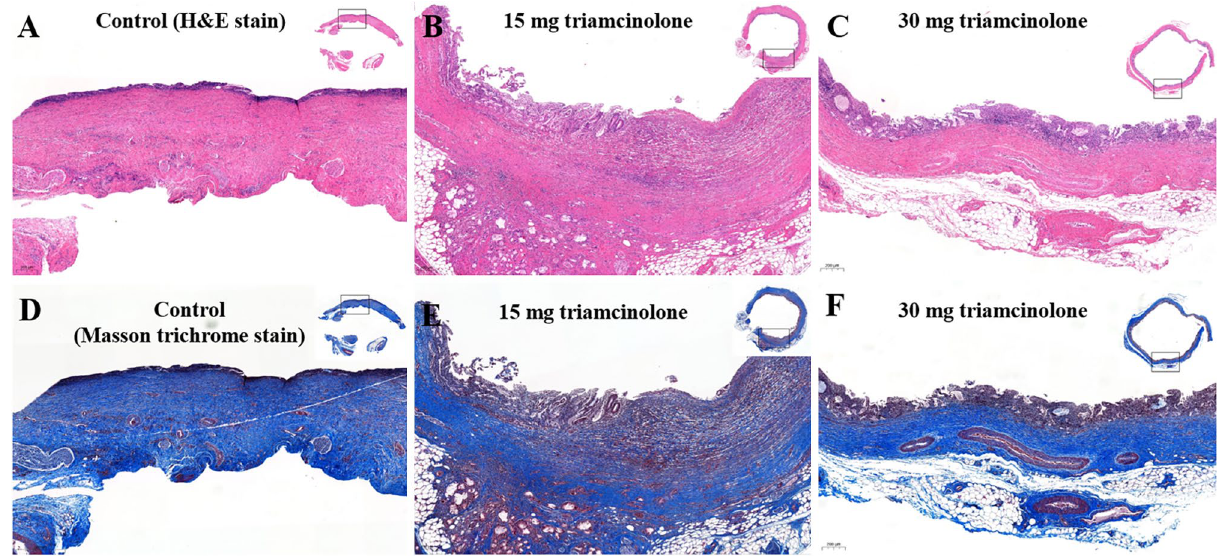
Figure 3. Microscopic pathology. Microscopic appearance of H&E-stained and Masson trichrome-stained sections of the bile duct 4 weeks after stent insertion. Control group ( A ) showing eroded epithelium, thick fibrosis, and moderate inflammation. Triamcinolone (15 mg) steroid-eluting stent group ( B ) showing residual erosion with regenerated epithelium, moderate inflammation, and partially resolved fibrosis. Triamcinolone (30 mg) steroid-eluting stent group ( C ) showing complete epithelial recovery, mild to moderate inflammation, and less fibrosis than the other